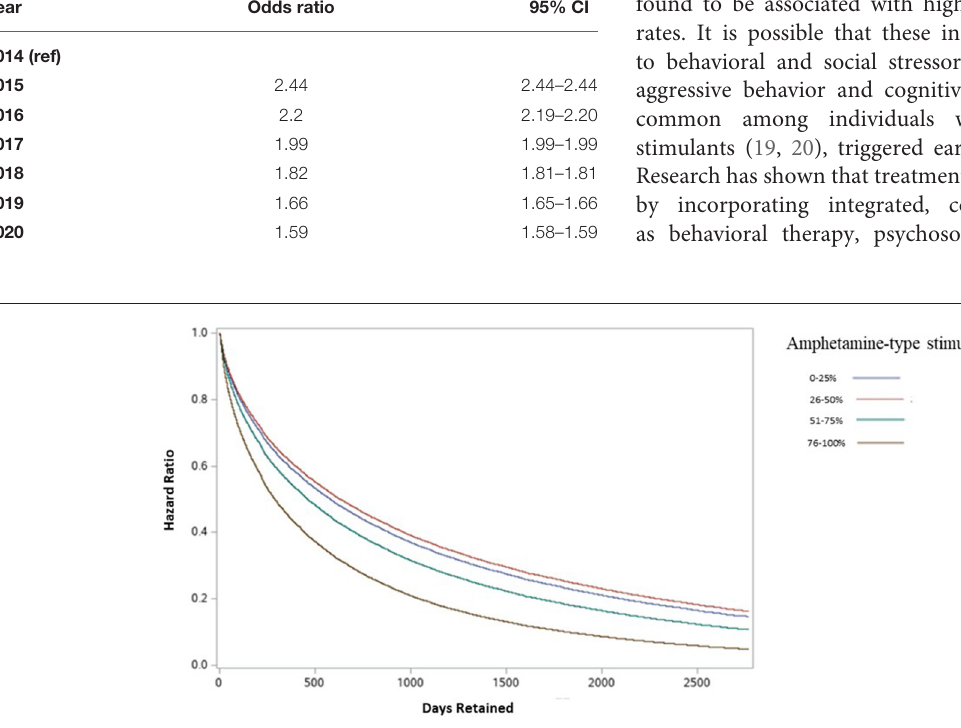
FIGURE 2 | Adjusted discontinuation probability between amphetamine-type stimulant groups among individuals in OAT in Ontario, Canada.